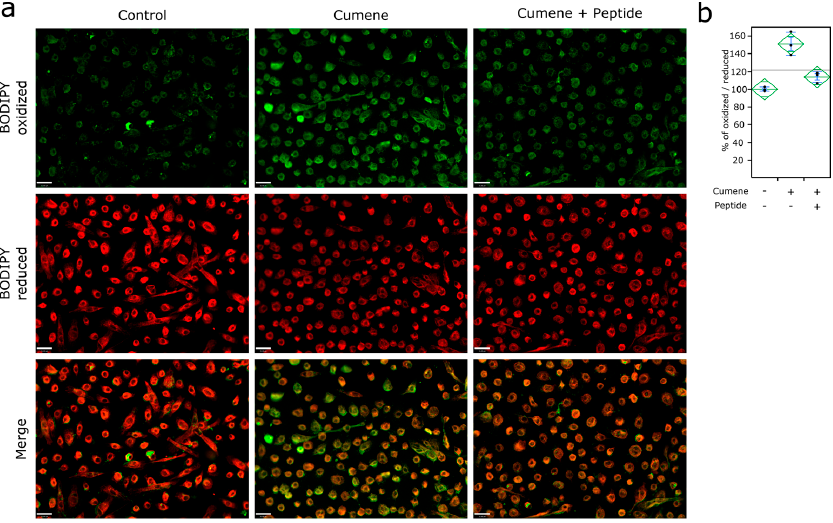
Figure 6. Ubiad1 protect keratinocyte plasma membrane from lipid peroxidation. ( a ) Lipid peroxidation detection in keratinocyte exposed 1 h to 200 µM cumene hydroperoxide (reduced BODIPY (boron-dipyrromethene) in red; oxidized BODIPY in green) (×20 objective lens, scale bar = 31 µm); ( b ) Lipid peroxidation quantification graph with One-Way Analysis of Variance, displaying confidence interval means diamonds (green). The line across each diamond represents the group mean. The vertical span of each diamond represents the 95% confidence interval for each group. Grand sample mean is represented by a horizontal black line.